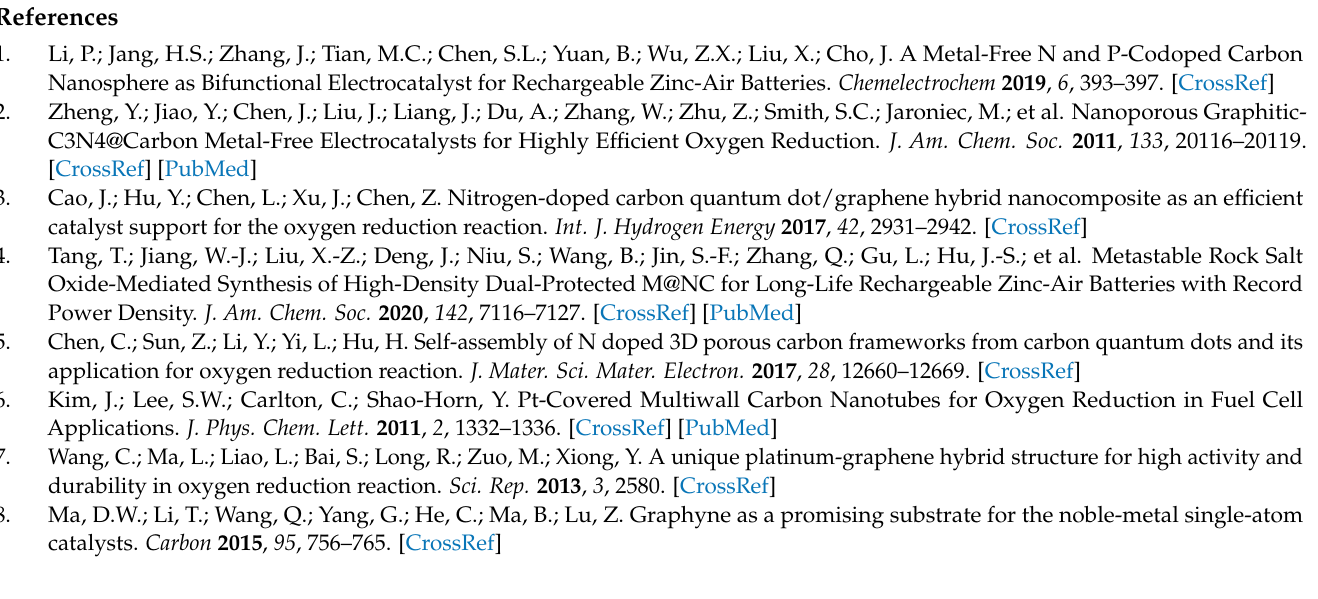
Co-CDs. Figure S4: FTIR spectra of CDs and Co-CDs. Figure S5: FTIR spectrum of